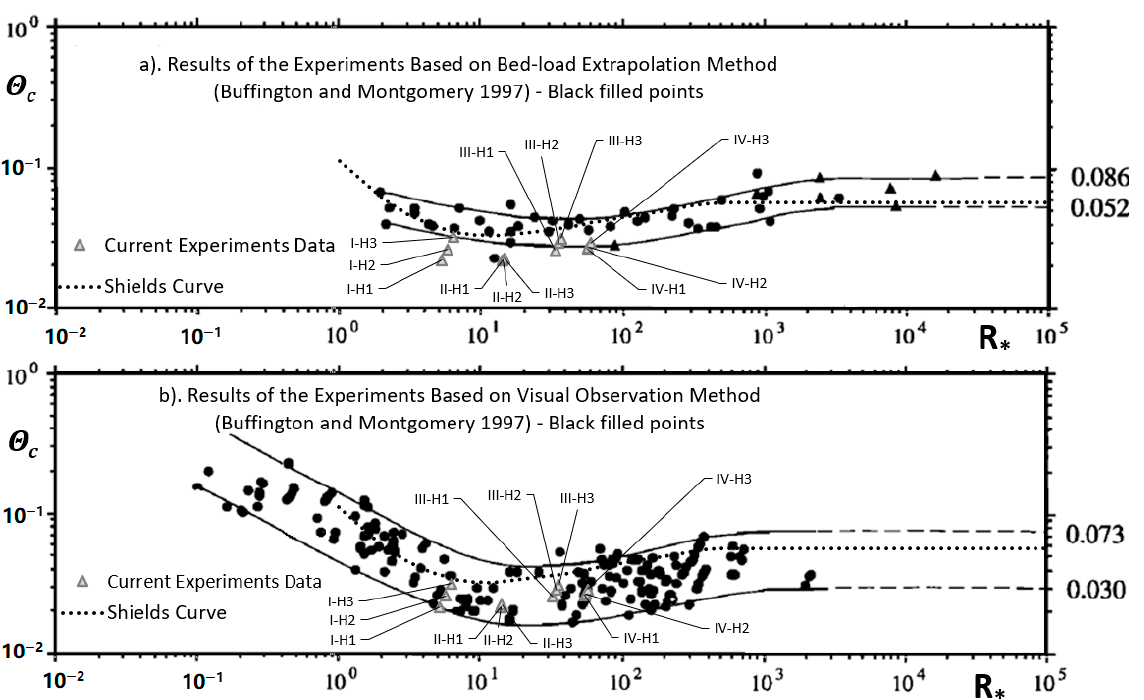
Figure 12. Comparison between critical Shields parameters of the present study and those of Buffington and Montgomery obtained via Bed-load Extrapolation Method ( a ) and Visual Observation Method ( b ) [5].